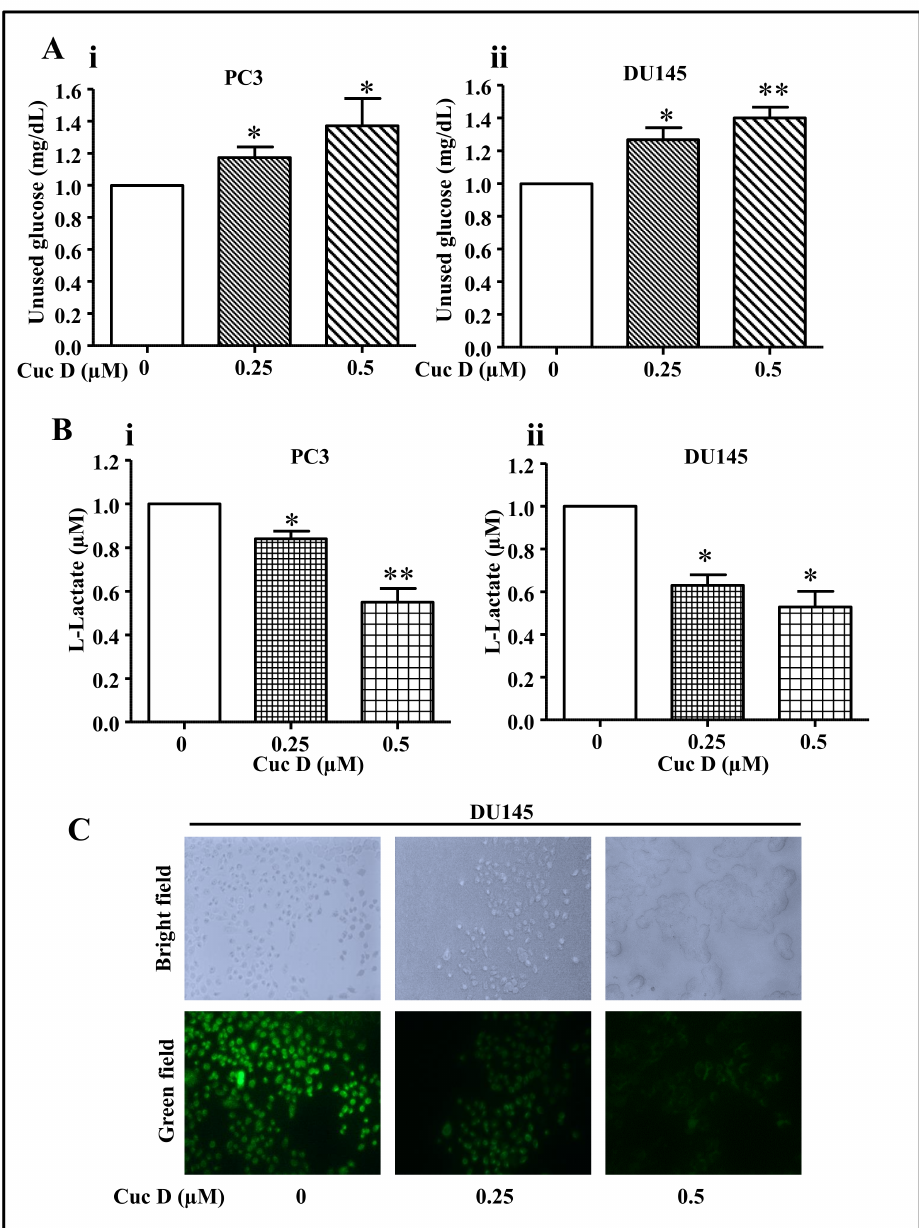
Figure 3. Effect of Cuc D on glucose uptake and lactate secretion by PrCa cells. ( A ) Effect of Cuc D on glucose uptake by PrCa cells as determined by glucose colorimetric assay kit (Cayman Chemicals, Ann Arbor, MI, USA). Bar graphs represent the unused glucose in PC3 ( Ai ) and DU145 ( Aii ) cells 24 h post-treatment of indicated concentrations of Cuc D. Asterisk indicate statistical significance determined by Student’s t -test (* p < 0.05 and ** p < 0.01). ( B ) Effect of Cuc D on lactate secretion by PrCa cells as determined by glycolysis cell-based assay kit (Cayman Chemicals, Ann Arbor, MI, USA). Bar graphs represent lactate secretion by PC3 ( Bi ) and DU145 ( Bii ) cells 24 h post-treatment of Cuc D. Asterisk indicate statistical significance determined by Student’s t -test (* p < 0.05 and ** p < 0.01). ( C ) Effect of Cuc D on glucose uptake as studied by fluorescence microscopy. Photomicrograph represents the uptake of fluorescent probe, 2-NBDG, by DU145 cells (20 × ). Briefly, cells were treated with Cuc D at indicated concentrations and uptake of 2-NBDG was analyzed by fluorescence microscopy. Green field images represent the fluorescent probe,